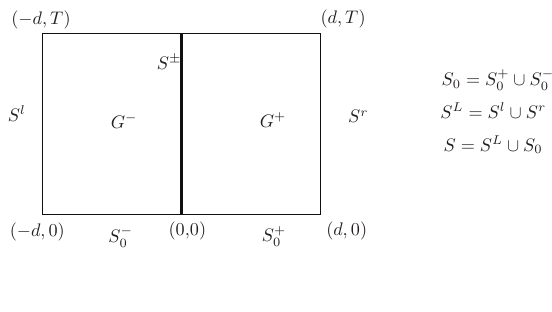
Figure 1. Sets of the